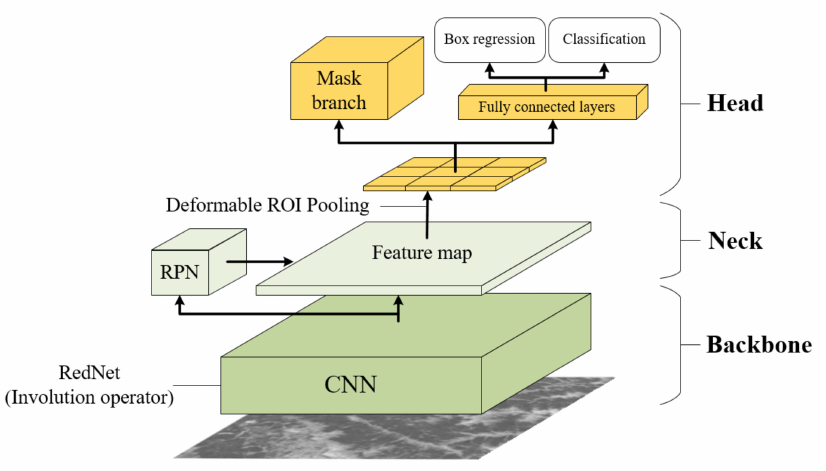
Figure 9. Architecture of InSARNet. (CNN: convolutional neural network, RPN: region proposal